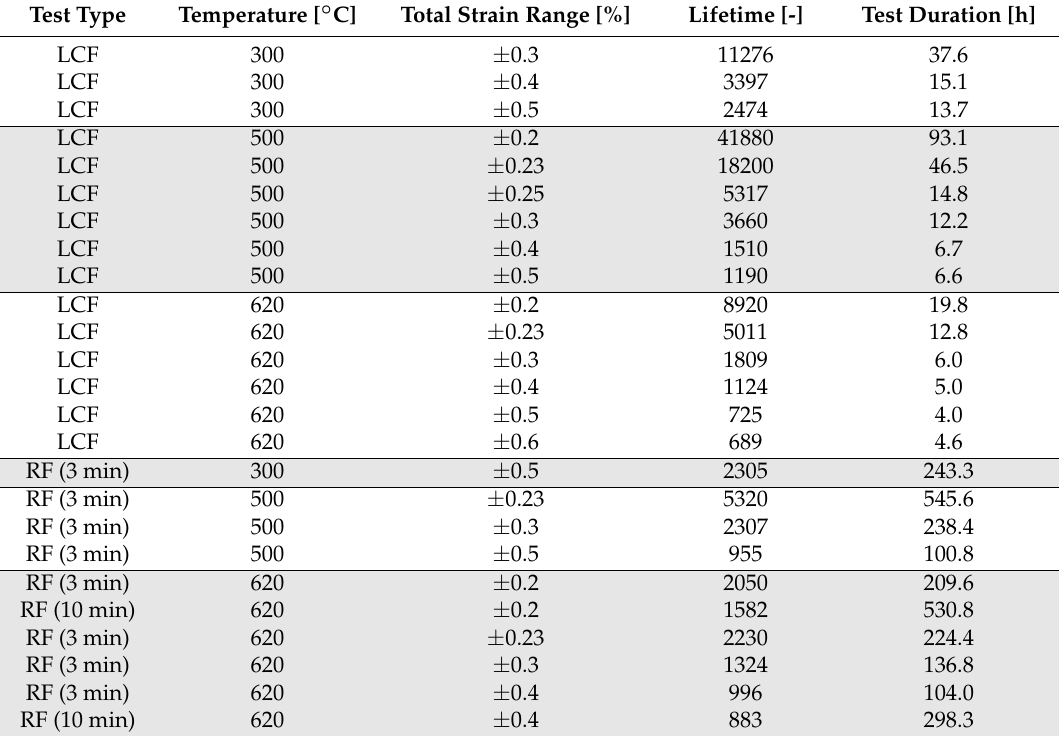
Table 3. Test parameters and lifetime of all conducted